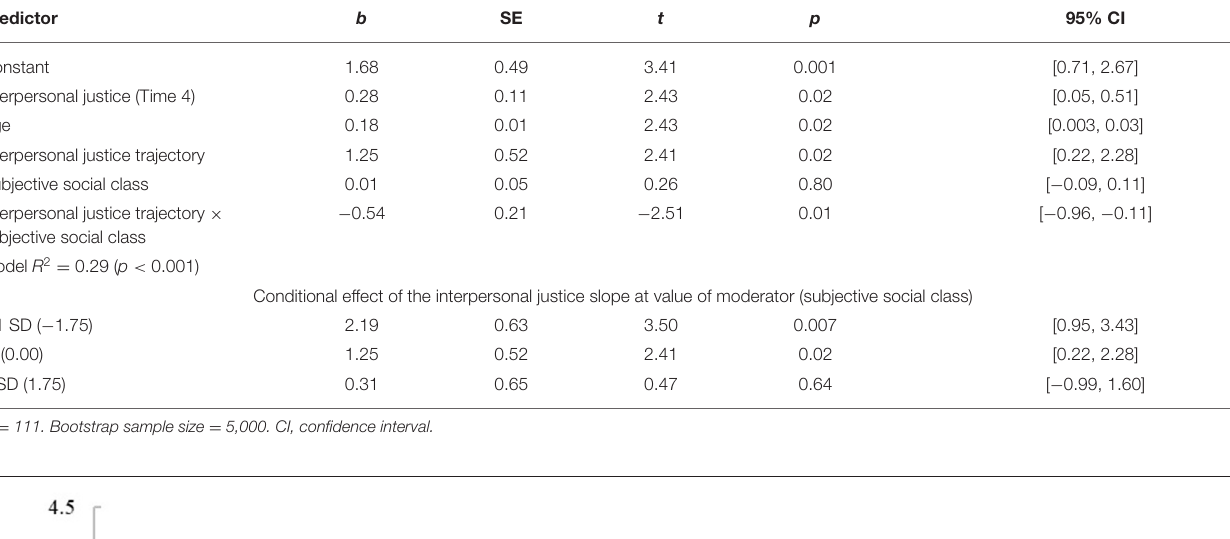
− 0.54 0.21 − 2.51 0.01